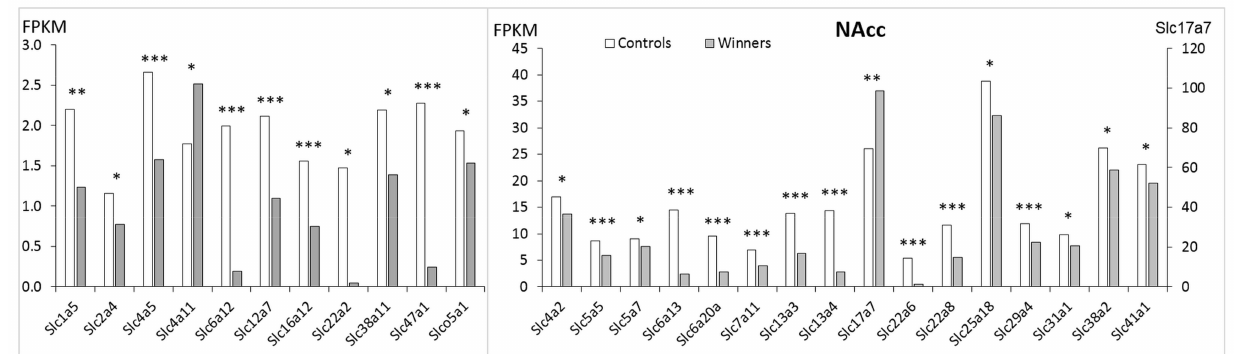
Figure 3. The Slc DEGs in the NAcc of mice. White columns: controls, grey columns: winners. *: p < 0.05; **: p < 0.01; ***: p < 0.001. Additional information is shown in Supplementary Table